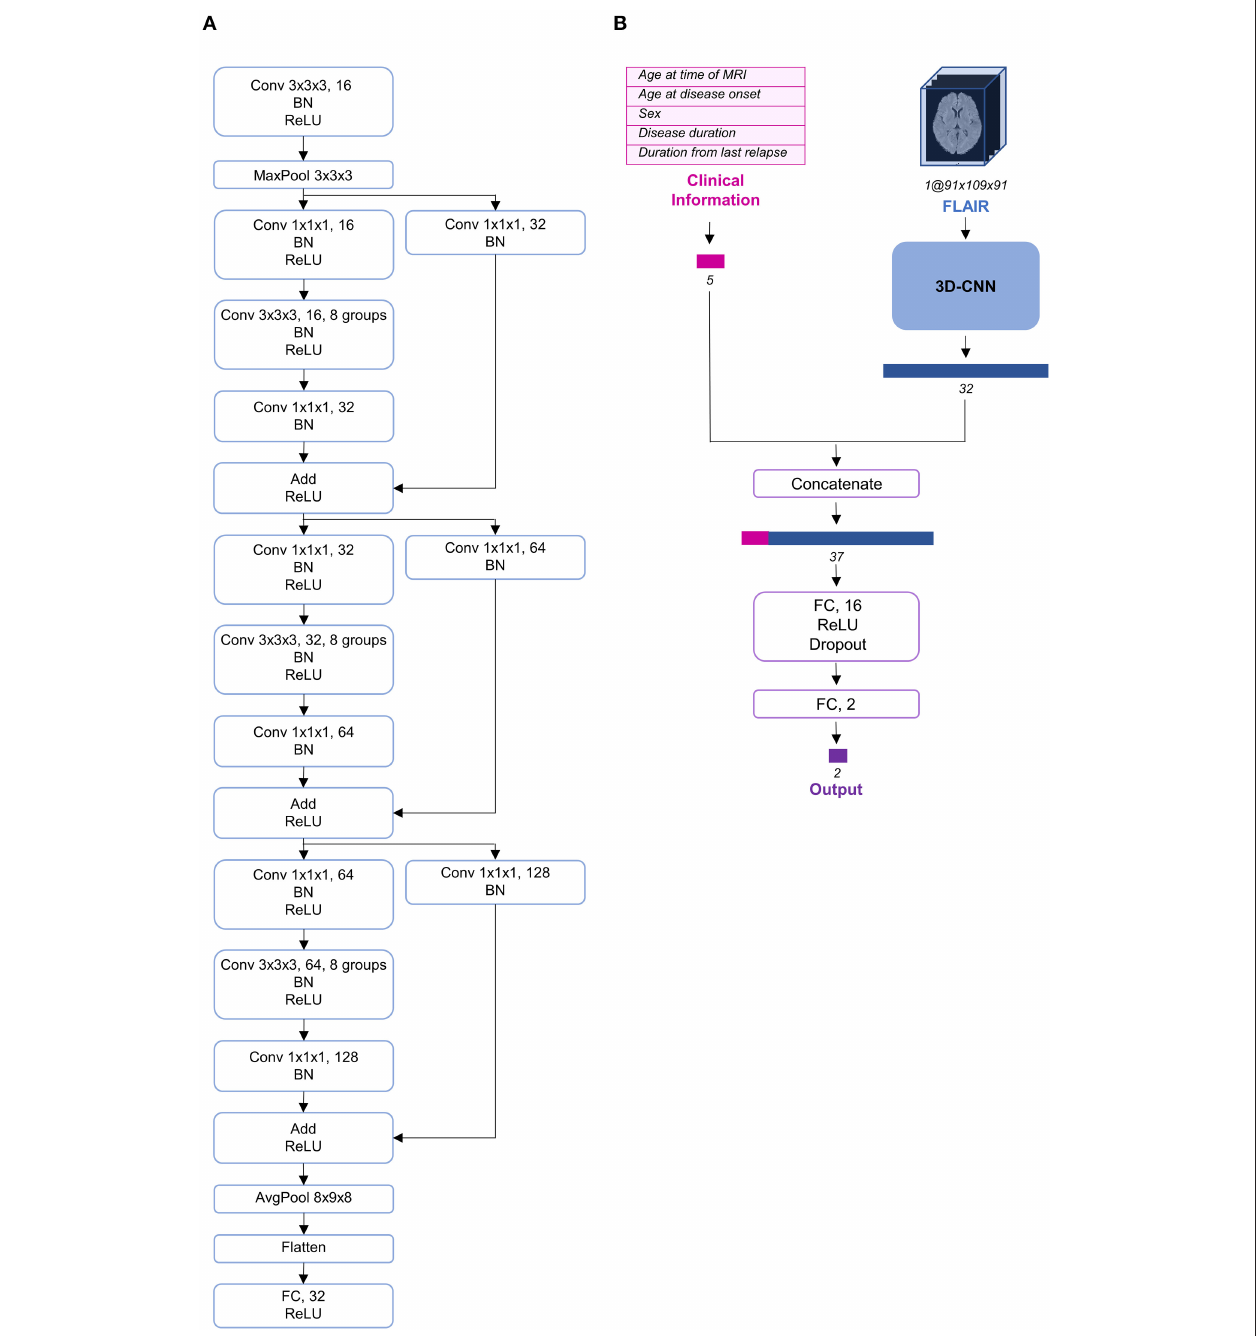
FIGURE 2 | Schema of the model architecture. (A) The 3D convolutional neural network architecture used in our study. (B) The entire structure of the proposed model. The preprocessed fluid-attenuated inversion recovery (FLAIR) image was transmitted through the 3D convolutional neural network (CNN) and its feature vector was extracted and concatenated with the preprocessed clinical information. AvgPool, average-pooling; BN, batch normalization; Conv, convolution; FC, fully connected; MaxPool, max-pooling; ReLU, rectified linear unit.